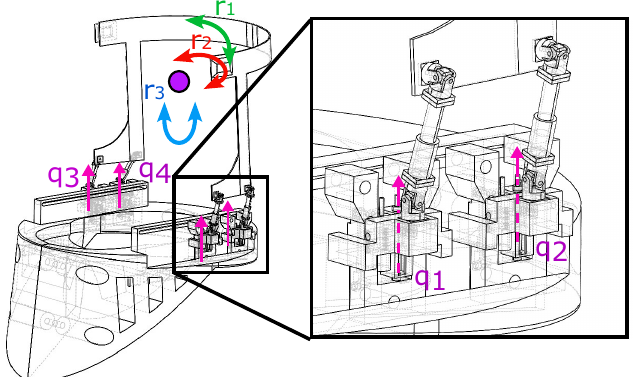
Figure 2. The mechanism of movement generated by a set of linear actuators. The closer view describes the position and orientation of the